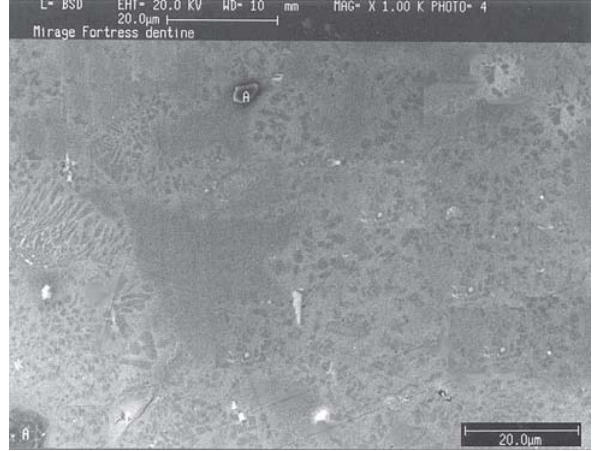
FIGURE 3- Photomicrograph of In-Ceram Alumina core ceramic (Vita Zahnfabrik, Bad Sackingen, Germany), a glass-infiltrated alumina based ceramic. BSI of the microstructure showing (A) alumina (Al in a lanthanum oxide base glass matrix